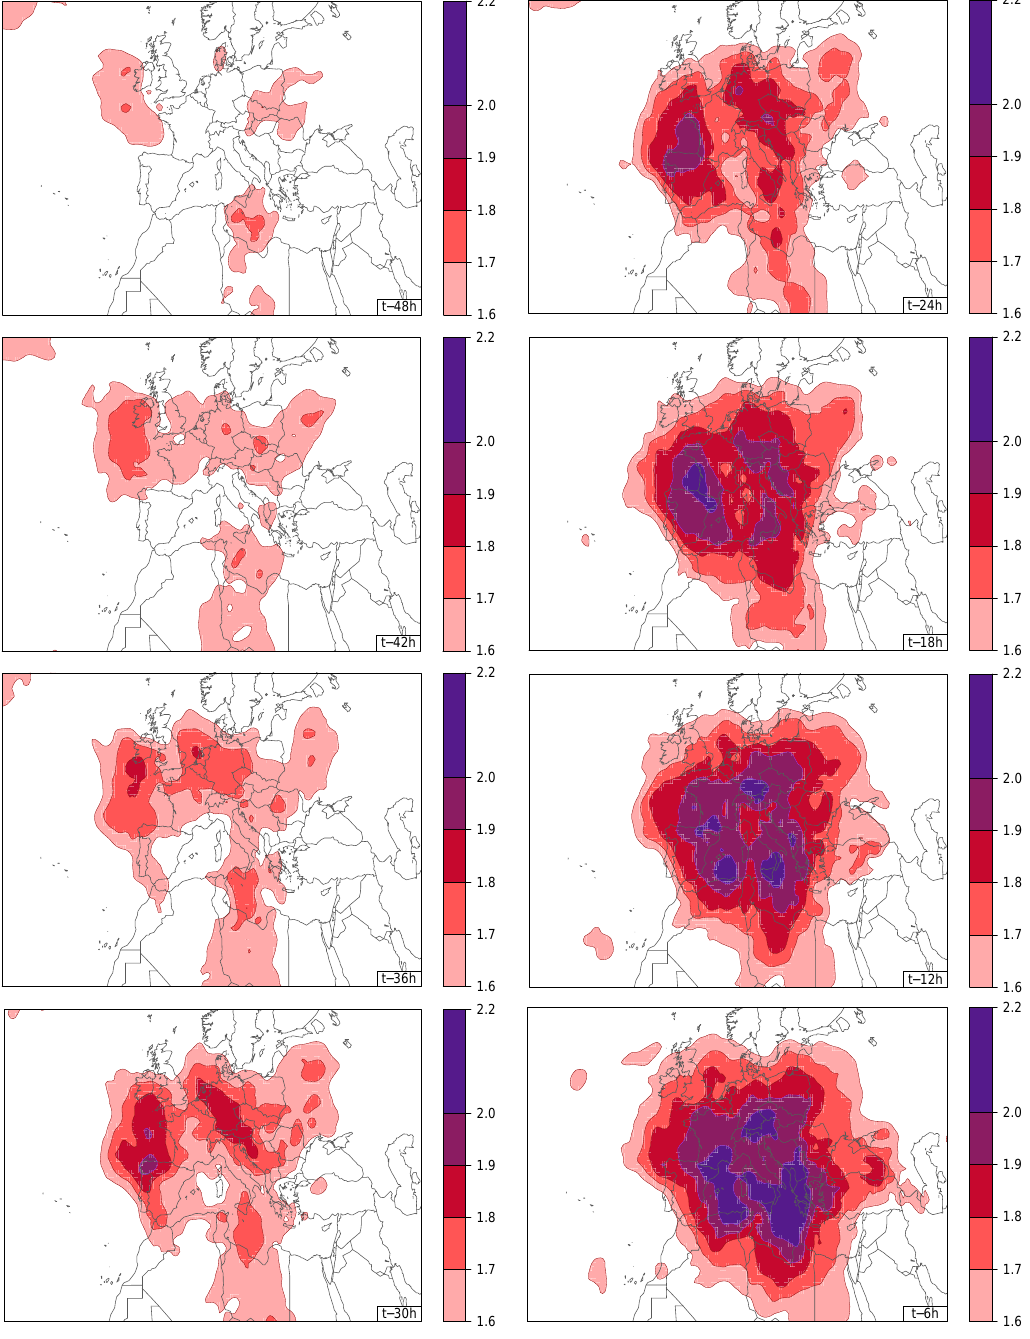
Fig. 6. Mean sensitivity fields for sufficiently populated clusters computed over all considered precursor conditions and levels (mb, shaded) from t − 48h to t − 6h every 6h (in order from left to right and top to